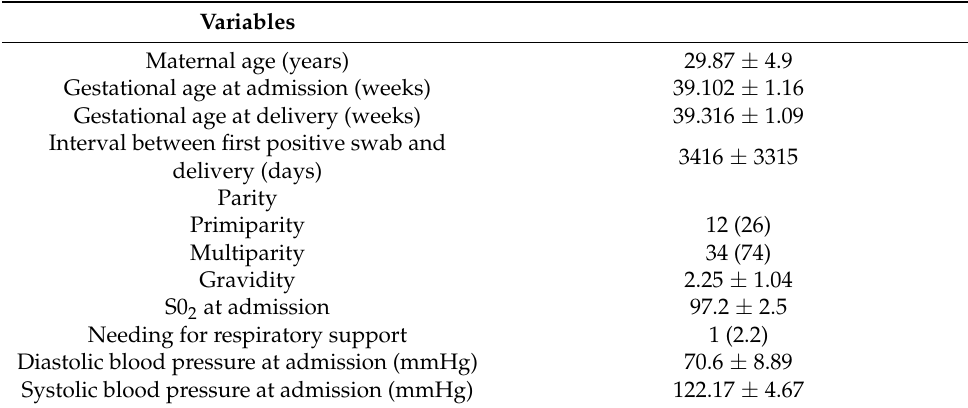
Table 1. Characteristics of the included